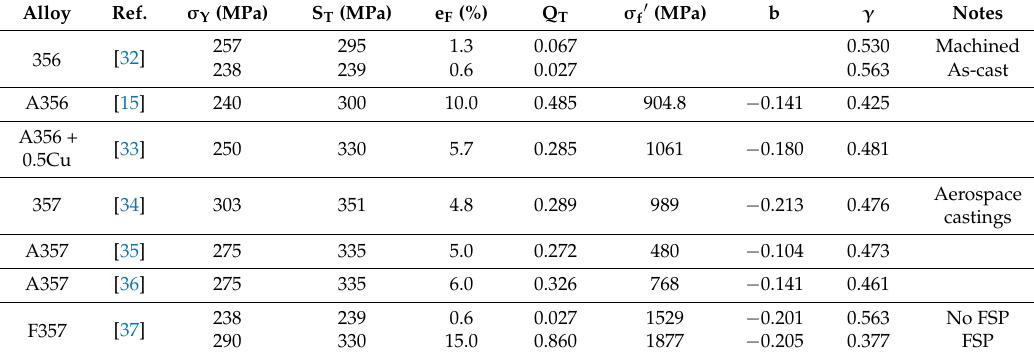
Table 1. Tensile data, quality index and estimated Basquin and Walker parameters for the nine